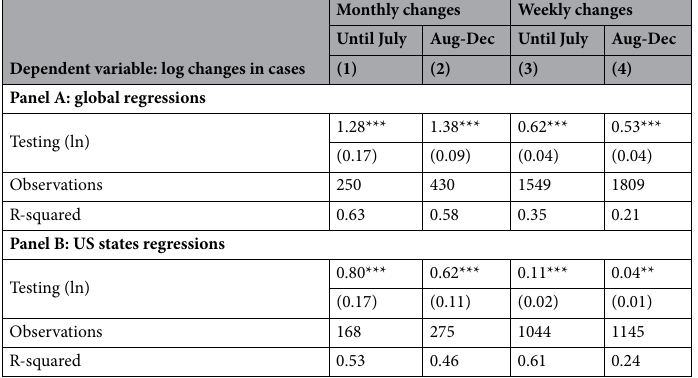
Table 3. Panel regressions with fixed effects by geography and period in 2020. * p < 0.05, ** p < 0.01, *** p < 0.001. Robust standard errors in parentheses. ln stands for natural logarithm. Because we control for fixed-effects in all regressions, all observed and unobserved invariant countries’ and US states’ characteristics are controlled for. Hence, we do not include covariates in these